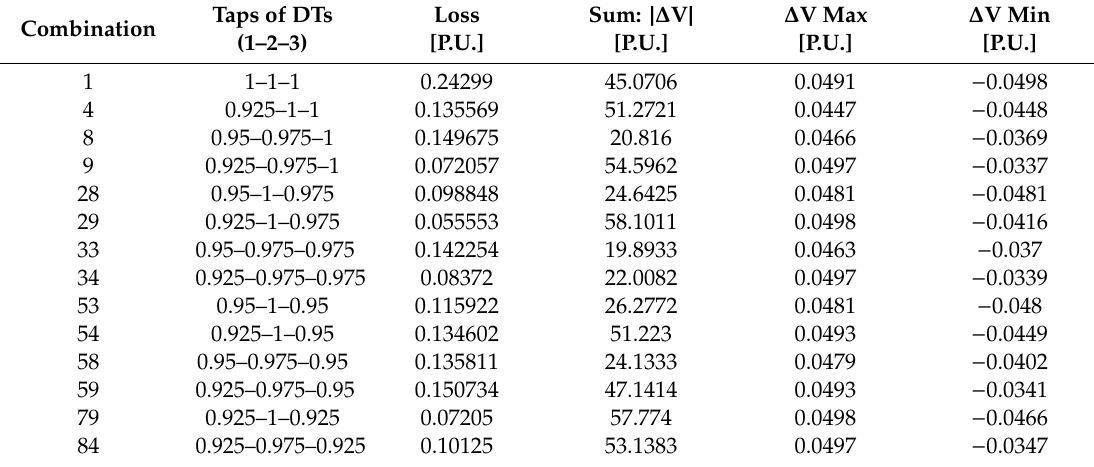
Table 2. The best combination of tap